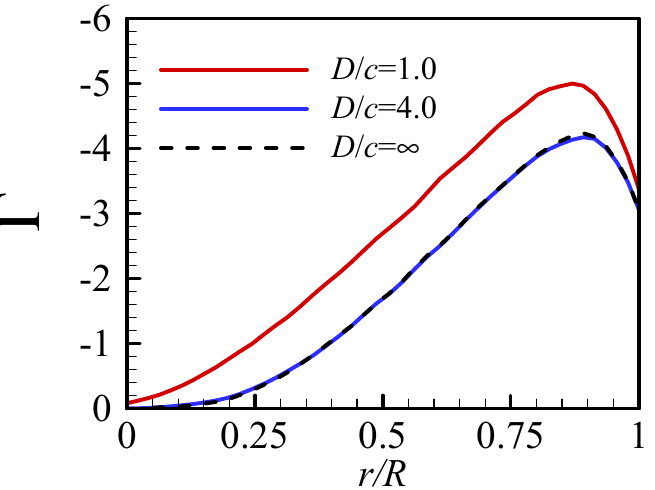
Figure 10. The change curves of LEV circulation along the wingspan in the middle of the first downstroke ( τ = 0.25) for D / c = 1.0, 4.0 and ∞ at Re = 10. To explain why there is larger positive pressure on the lower wing surface for the combined ceiling and ground case, the velocity vectors in the inertial frame around the wing section, plus the pressure contours, are plotted in Figure 11. It is found that due to the restriction of the ground at D / c = 1.0, a narrow channel is formed between the trailing edge of the wing and the ground, and the velocity vectors are ‘squeezed’ to align more horizontally than that at D / c = 4.0 and D / c = ∞ . This leads to a larger pressure on the lower surface in Figure 8, which is also evident in the pressure contour distribution and the high-pressure area encircled by the single contour line with a value of 2.0 in Figure 11b. As the clearance increases to D / c = 4.0, the air squeezing effect is very weak, the vectors are almost the same between the D / c = 4.0 and ∞ , and finally, the pressure distributions of these two cases are almost the same.